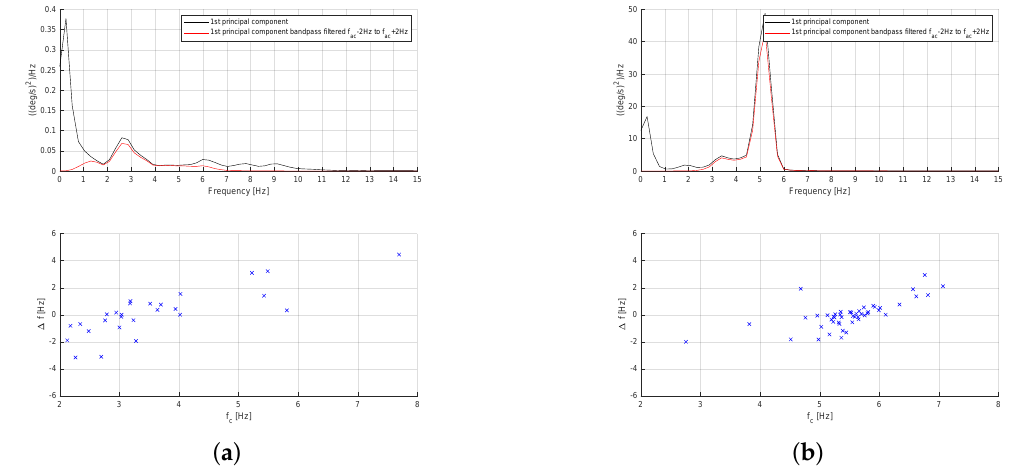
Figure 9. Power spectral density and Inter-cycle variation of gyroscope signal frequency measured at the head of a patient with cervical dystonia. ( a ) Patient-1, without head tremor (from A1 group); ( b ) Patient-28, with head tremor (from B1